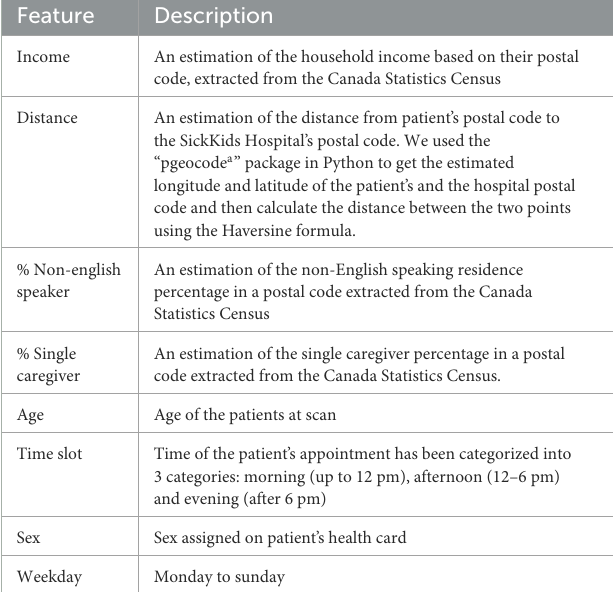
TABLE 1 Description of features used in our